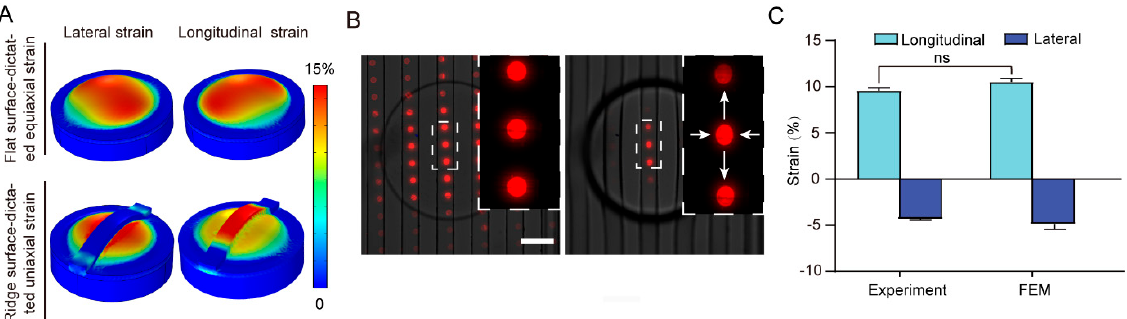
Figure 3. Characterization of the uniaxial strain property of the stretching chip. ( A ) Lateral and longitudinal strain field distribution of the pressure cavity with a flat surface (up panel) and ridge structure (down panel) based on FEM. ( B ) Representative phase and fluorescence images showing the deformation of the pressure cavity and fluorescent dots under 0 bar pressure (left panel) and 0.5 bar pressure (right panel), respectively. Scale bar: 200 μ m. ( C ) Quantitative data showing the lateral and longitudinal strain from experimental and FEM simulation assays ( p = 0.100, ns).